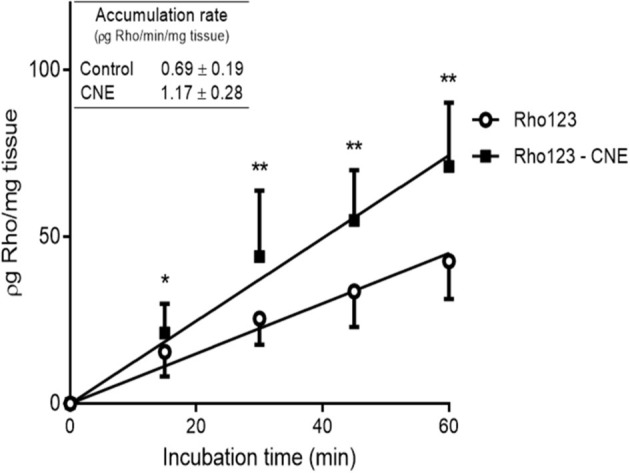
Accumulation of Rhodamine 123 (Rho123) in bovine ileal explants after incubation in absence or presence of R-carvone (R-CNE). The inserted table shows the rates of accumulation of Rho123 (ρg Rho/min/mg tissue). Data are the mean (±SD) of 16 determinations. Significantly different from control incubations (Rho123 alone) at *p < 0.05 and **p < 0.01.